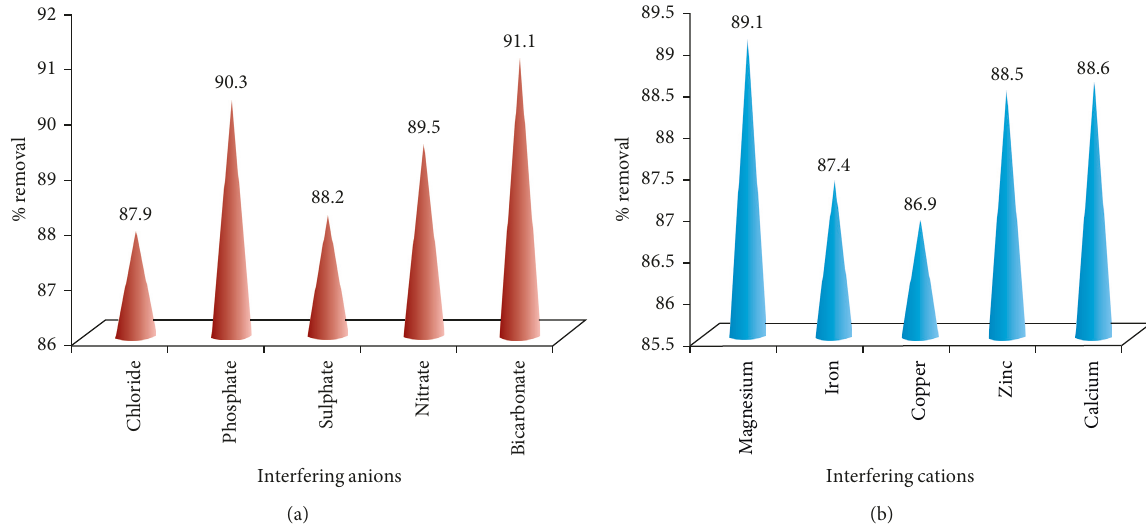
Figure 11: (a) Effect of interfering anions on adsorption of lead. (b) Effect of interfering cations on adsorption of